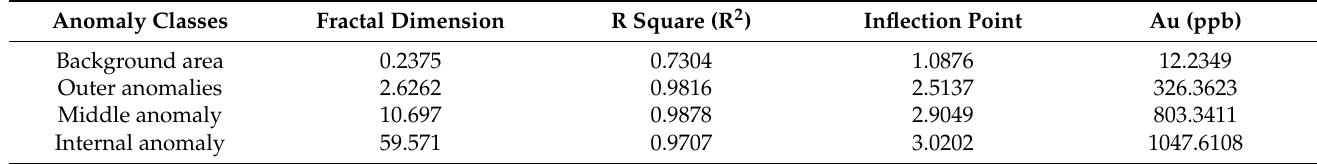
Table 1. Fractal characteristics of 3D Au data volume model.